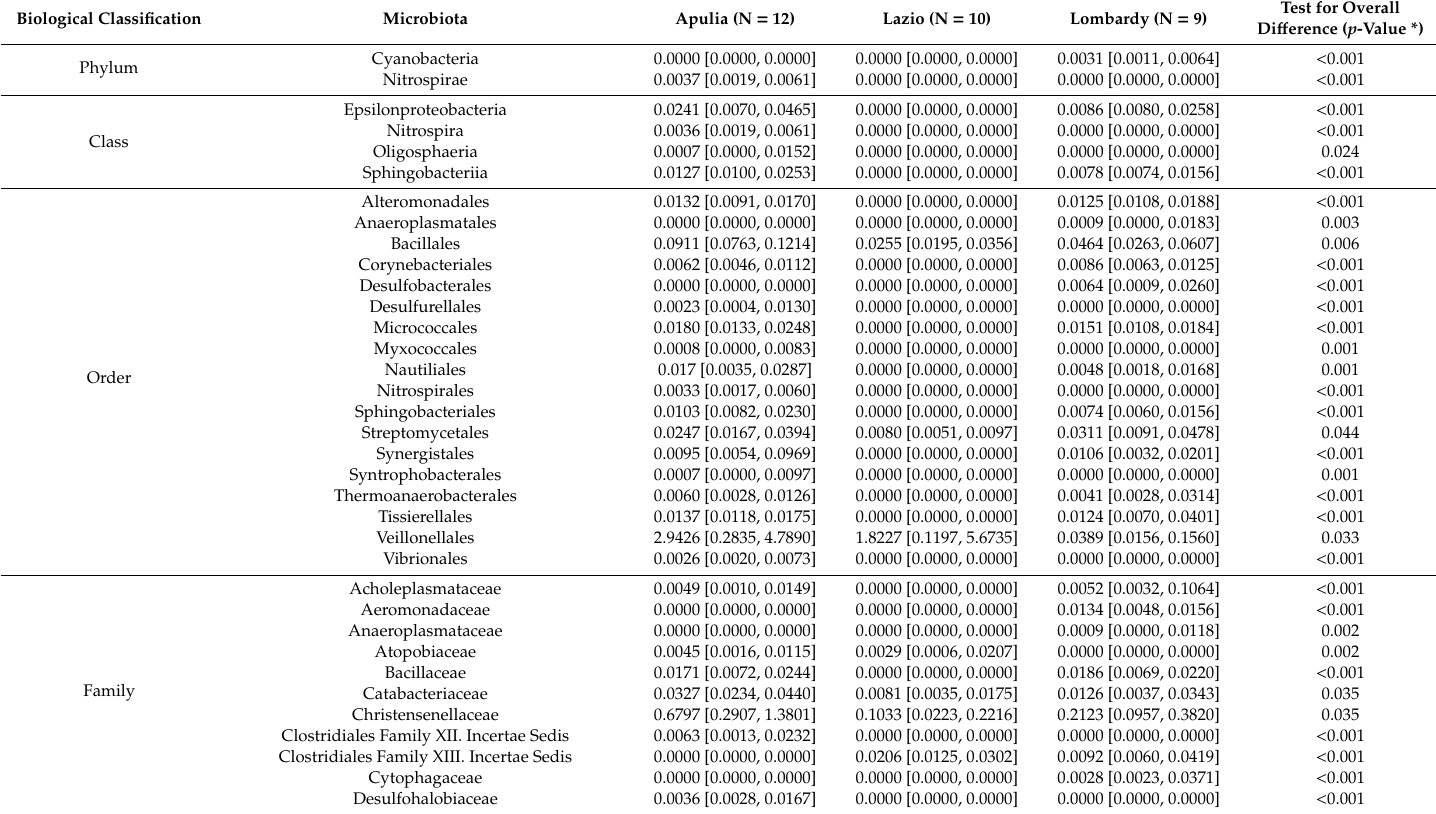
Table 3. Gut microbiota in subjects grouped by Italian regions. Data were reported as median along with interquartile range (first-third quartiles). Only significant results (i.e., p -values < 0.05 from any statistical test) were reported. All p-values were adjusted controlling for the False Discovery Rate at 0.05 level within each taxonomic